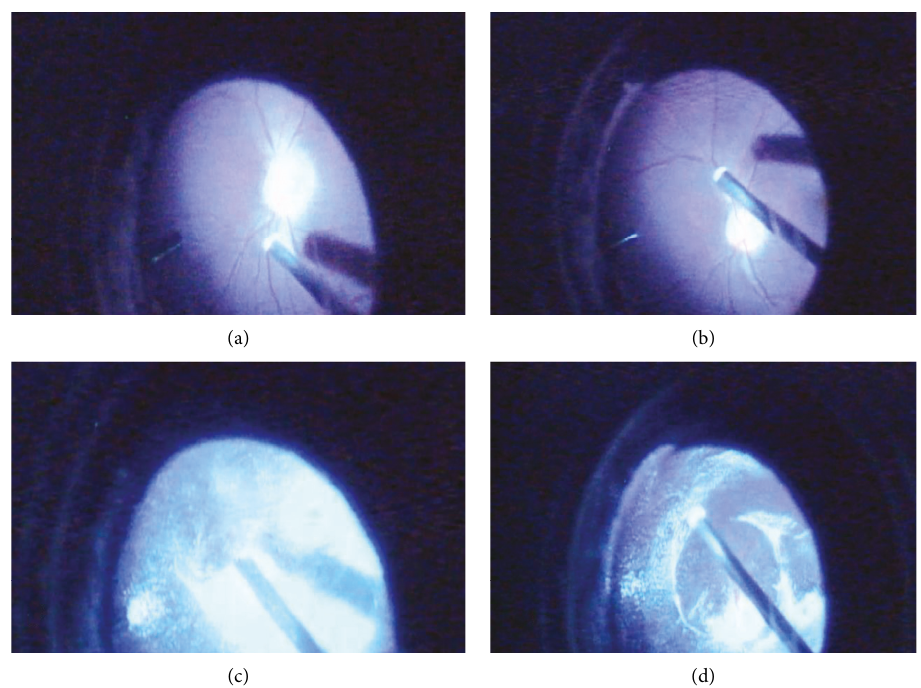
Figure 1: Formation of surgical posterior vitreous detachment (PVD). (a) The attraction of the vitreous cortex with high vacuum levels transmitted through the vitrectomy probe, over the optic nerve. (b) The vitreous cortex is gently pulled up by the vitrectomy probe. (c) Suspension of triamcinolone acetonide granules in the vitreous cavity. (d) Successful surgical PVD is confirmed by the appearance of a peripapillary Weiss ring.